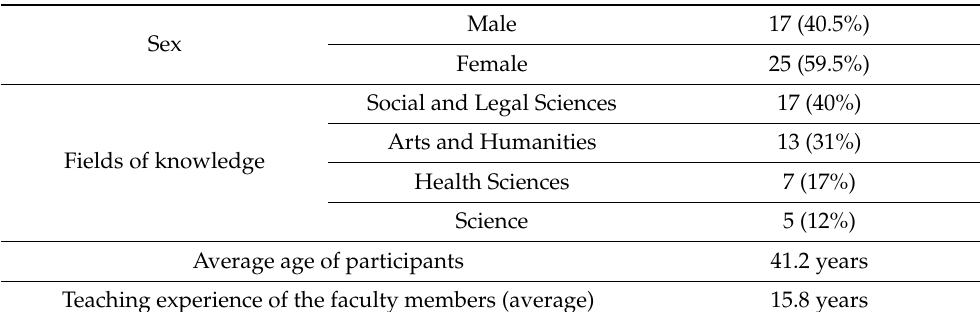
Table 1. Profile of the